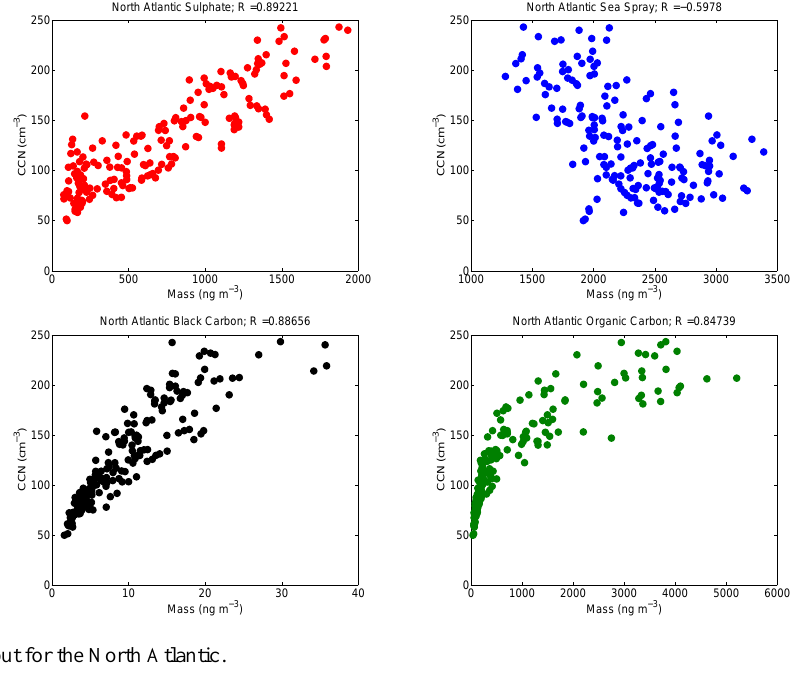
Figure 7. As for Fig. 6, but for the North Atlantic.